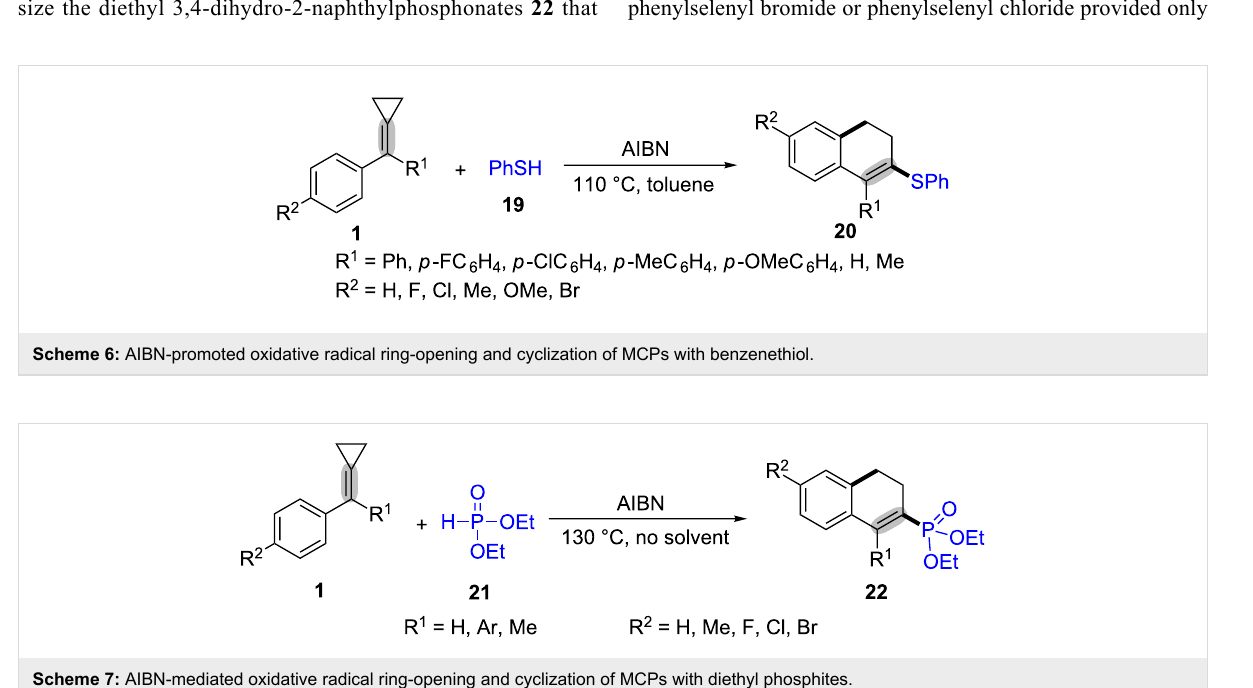
thiol ( 19 ) for the synthesis of